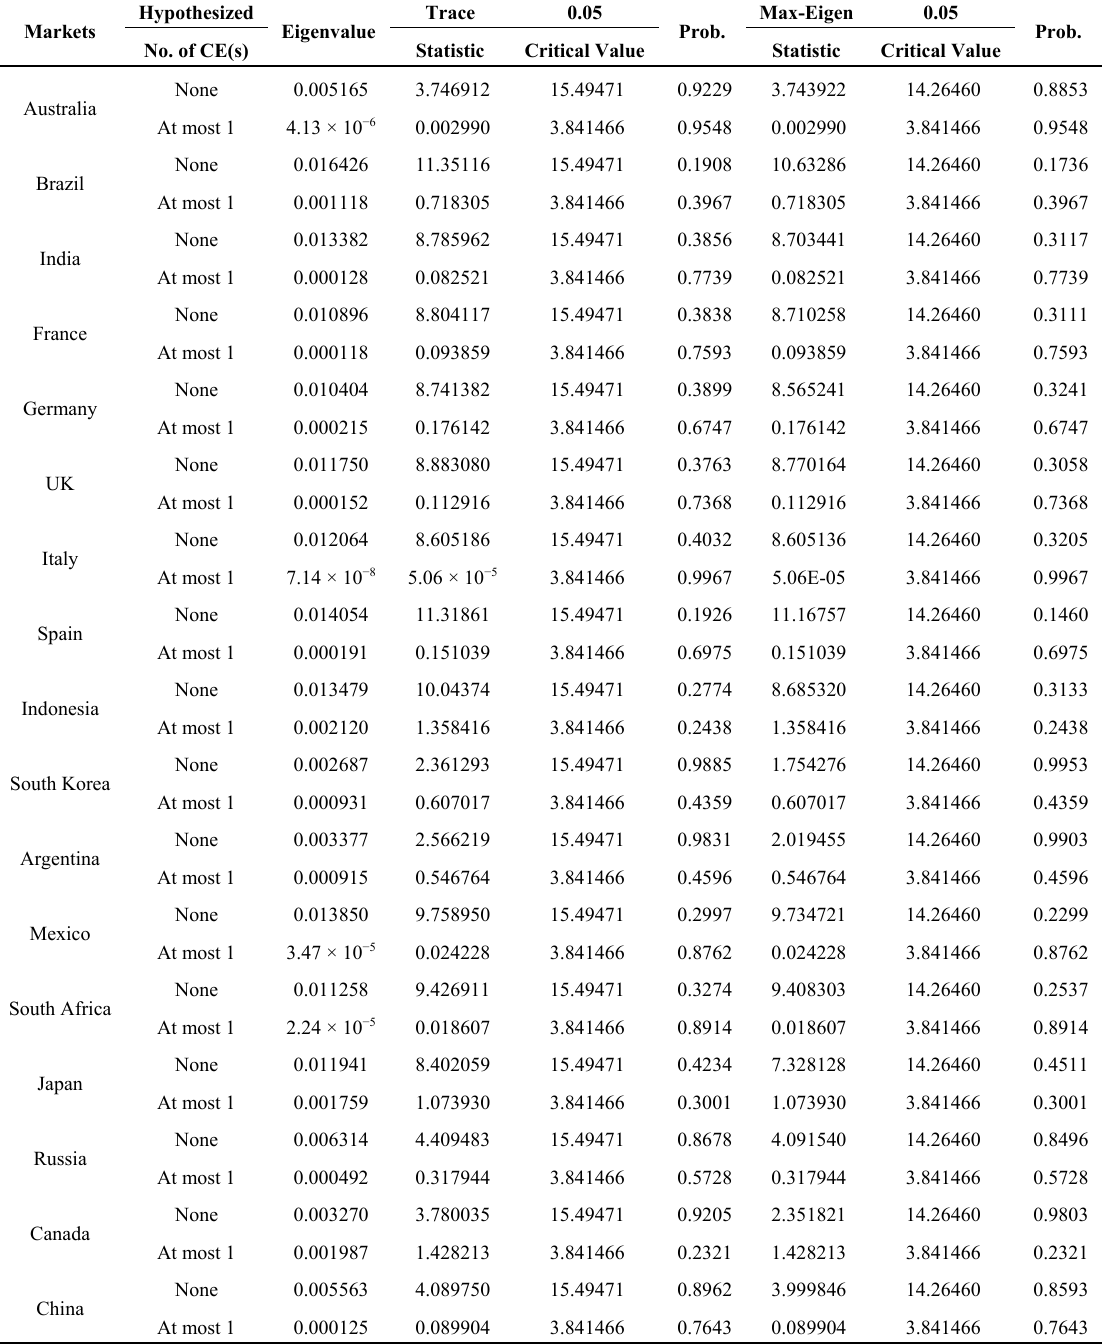
Table A11. Test for Johansen Cointegration in Sub-period